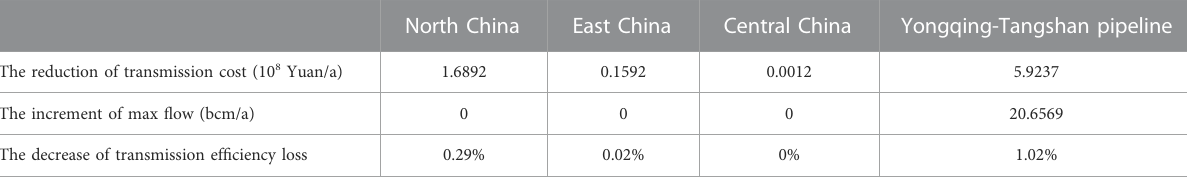
TABLE 2 Impacts of reducing interdicted cost on transmission cost, max fl ow, and transmission ef fi ciency